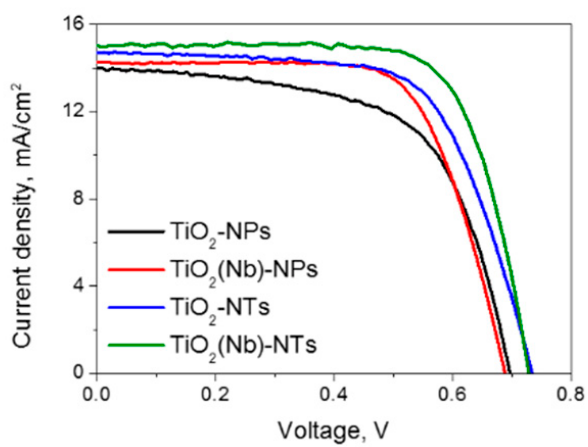
Figure 4. The current density-voltage curves of best-performing dye-sensitized solar cells (DSCs) fabricated with TiO 2 NPs- and NTs-based photoelectrodes.